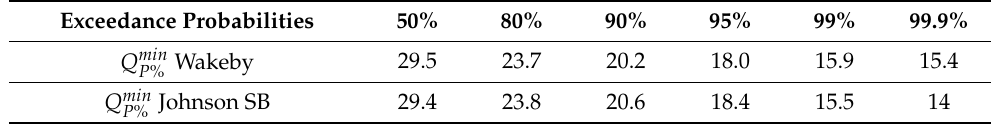
Table 1. Minimum drought discharges at Lungoci gaging station (m 3 /s).